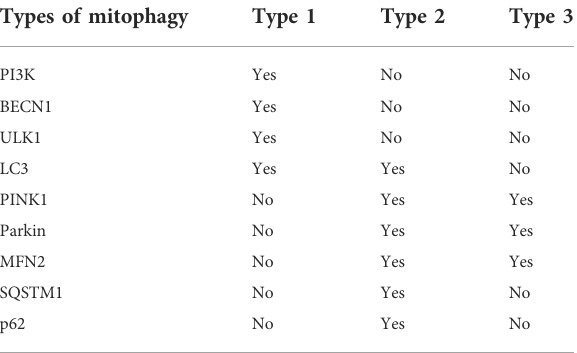
TABLE 1 Characteristics of the three types of